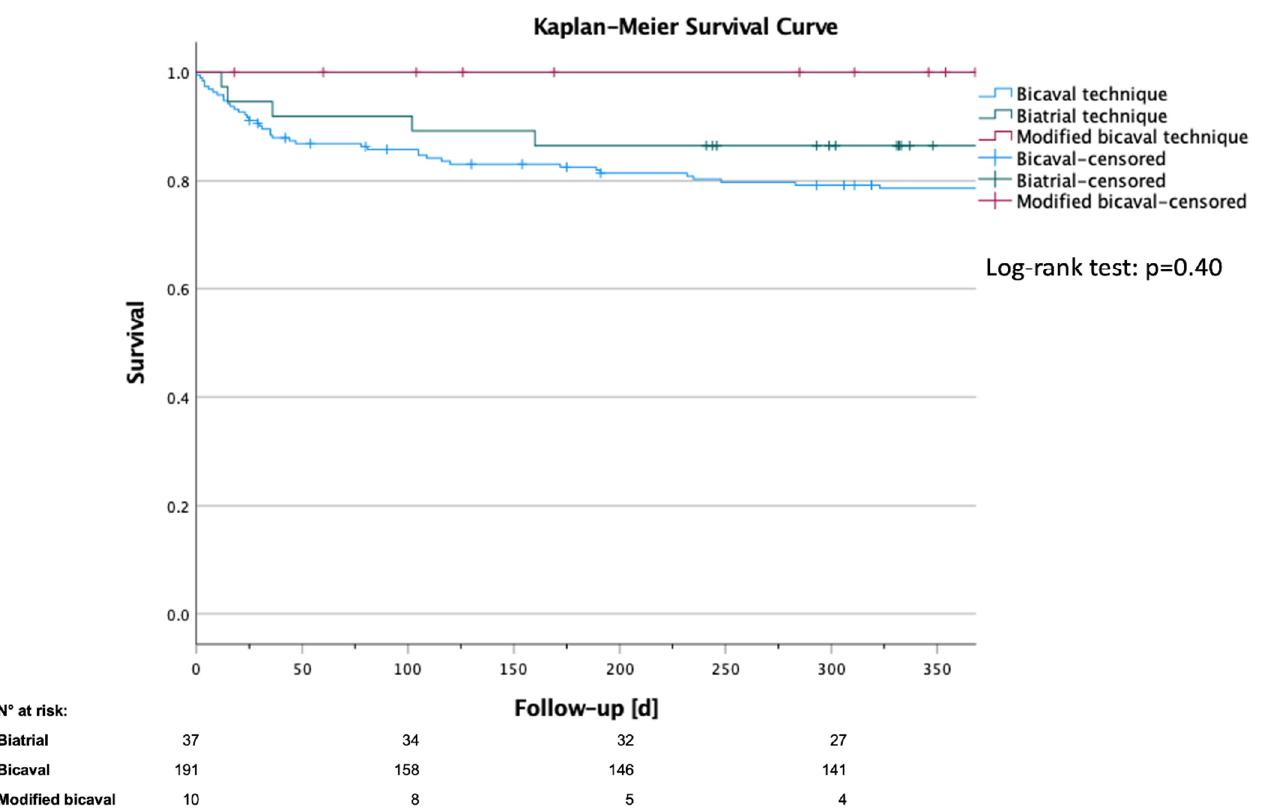
Figure 3. Kaplan-Meier survival curve after heart transplantation. Comparison of biatrial (n = 37), bicaval (n = 191) and modified bicaval (n = 10) anastomoses technique. Patients were censored when they reached the end follow-up period. Log-rank test: p = 0.40.